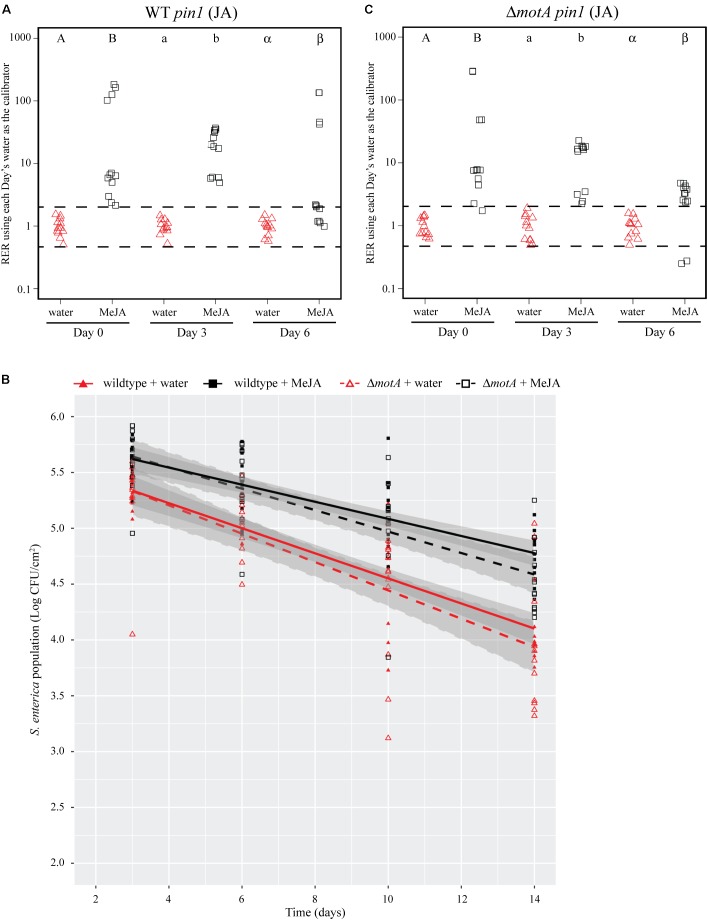
Induction of the JA response with a chemical analog increases S. Typhimurium survival over time. (A,C) Plant pin1 gene expression was quantified at days 0, 3, and 6 post-inoculation with wildtype S. Typhimurium (A) or the motA::Kan mutant (C) for plants sprayed with water (red triangles) or MeJA (black squares) and displayed as relative expression ratios (RER) using transcription on plants treated with water as the calibrator. The dashed line indicates a twofold change in transcription, and each symbol represents data collected from one tomato plant. Transcript levels were quantified from three biological replicates with samples taken from four plants per treatment per time point. Letters denote significant differences between treatments within a single time point (P < 0.05). (B) Bacterial populations on leaves were monitored over time following either treatment with water (red triangles) or MeJA (black squares) 24 h prior to bacterial dip inoculation. All data points from three independent experiments were combined and presented as S. Typhimurium populations (log CFU/cm2) over a 14-day period. Lines (red, solid: wildtype S. Typhimurium after water treatment; black, solid: wildtype S. Typhimurium after MeJA treatment; red, dashed: motA::Kan after water treatment; black, dashed: motA::Kan after MeJA treatment) correspond to a linear regression model, and shaded areas correspond to the respective 95% confidence interval.